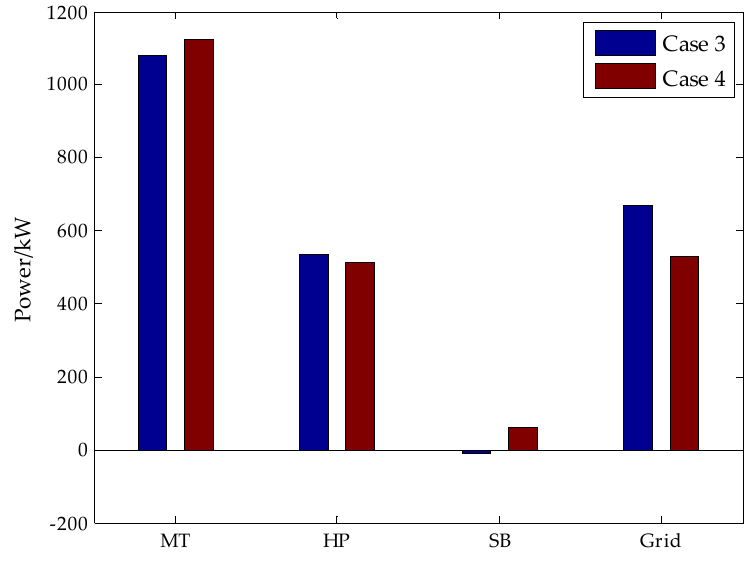
Figure 6. Changes in equipment output in summer.